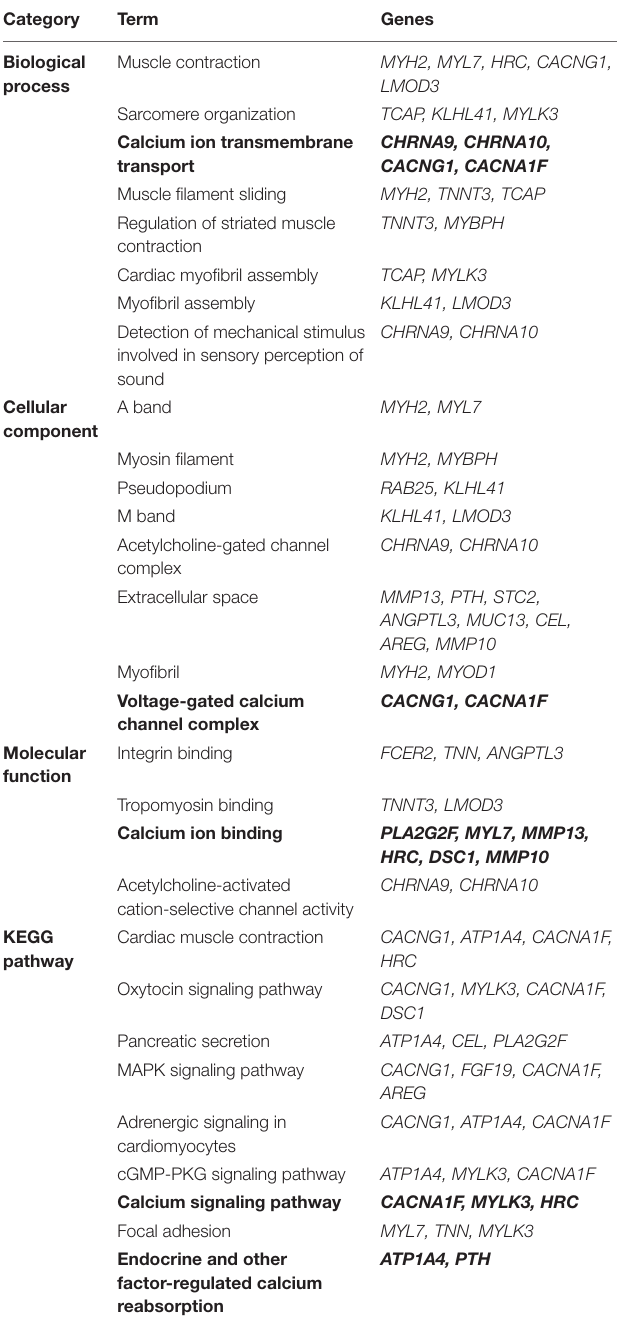
TABLE 2 | GO enrichment and KEGG pathway analysis of the same DEGs in VZV infected SH-SY5Y cells and VZV induced PHN rats